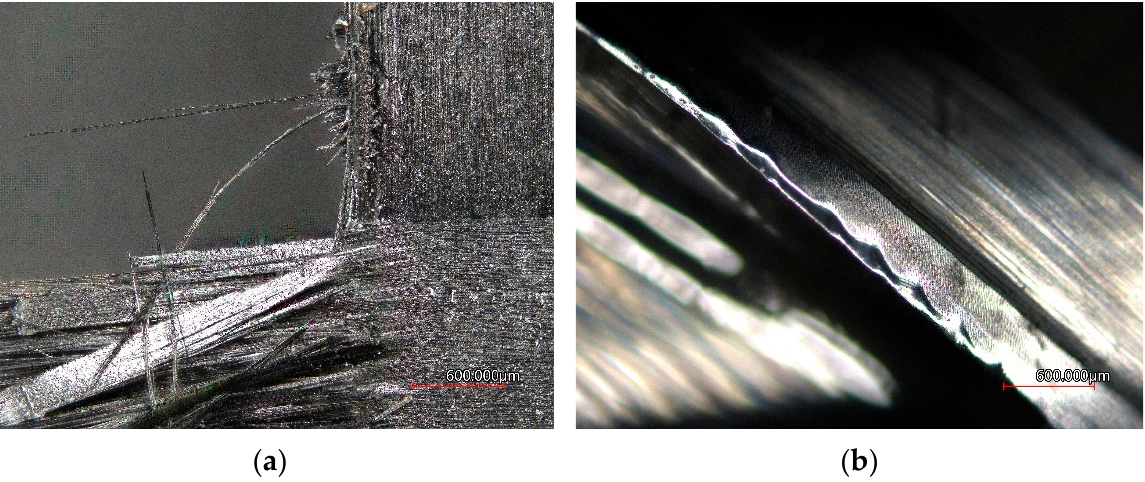
Figure 10. Capture after a tool tooth path of 15 × 165 m. ( a ) Laminate thickness 3 mm; ( b ) A100 milling tool.